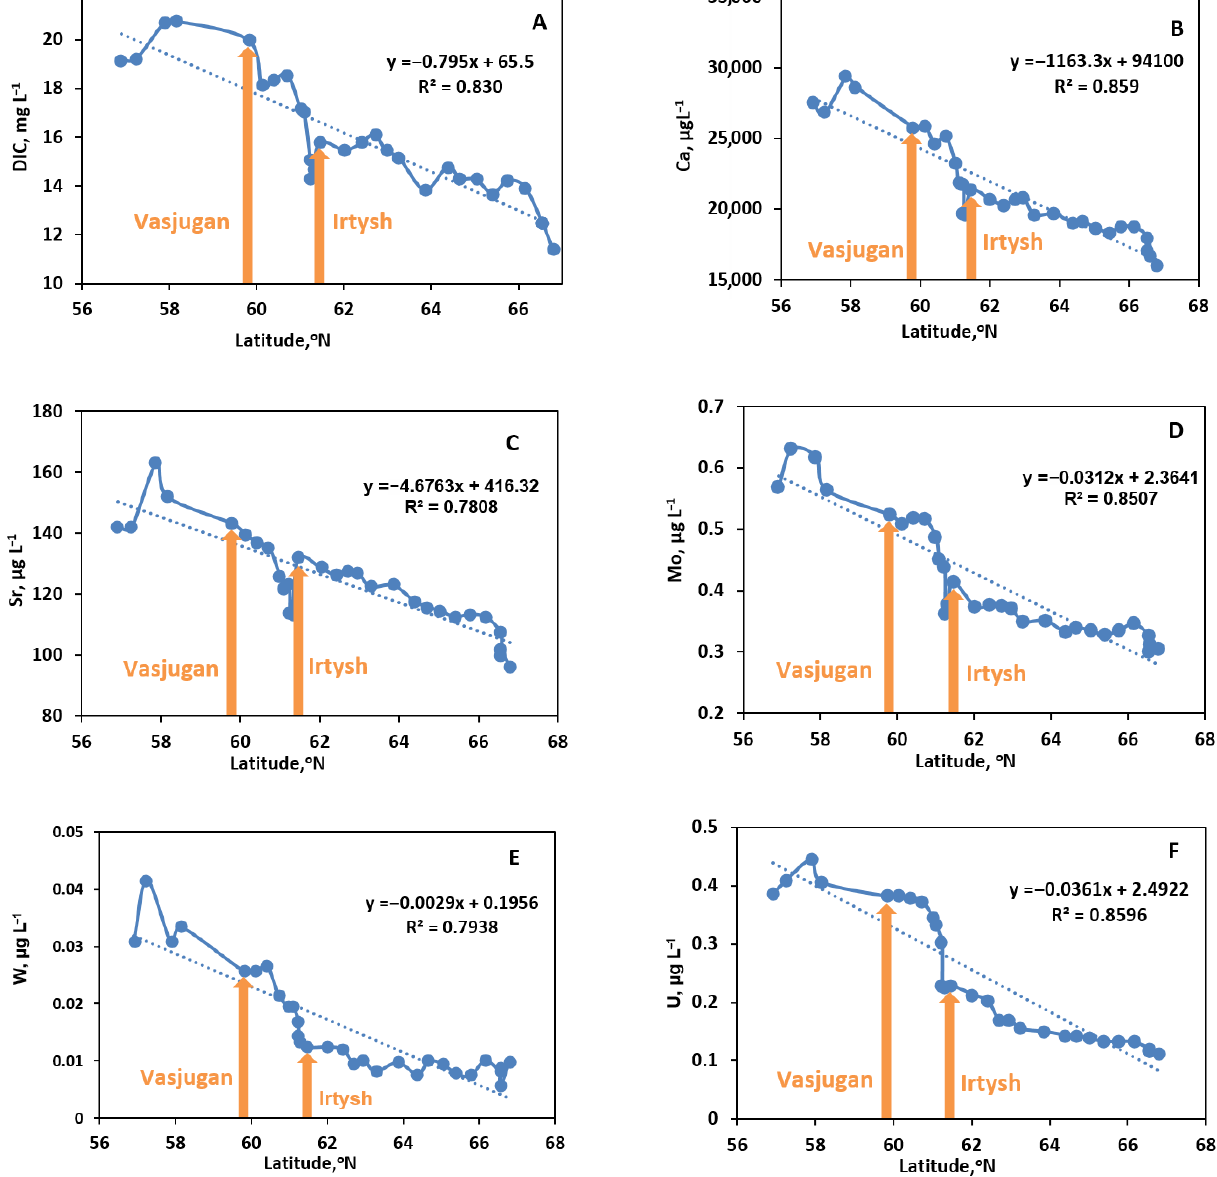
Figure 2. Latitudinal trends of labile major and trace elements decreasing their concentrations in the main stem of the Ob River from the south to the north: DIC ( A ), Ca ( B ), Sr ( C ), Mo ( D ), W ( E ) and U ( F ). The two main tributaries likely to control DOC and trace metal delivery, rivers Vasjugan and Irtysh, are shown by arrows.